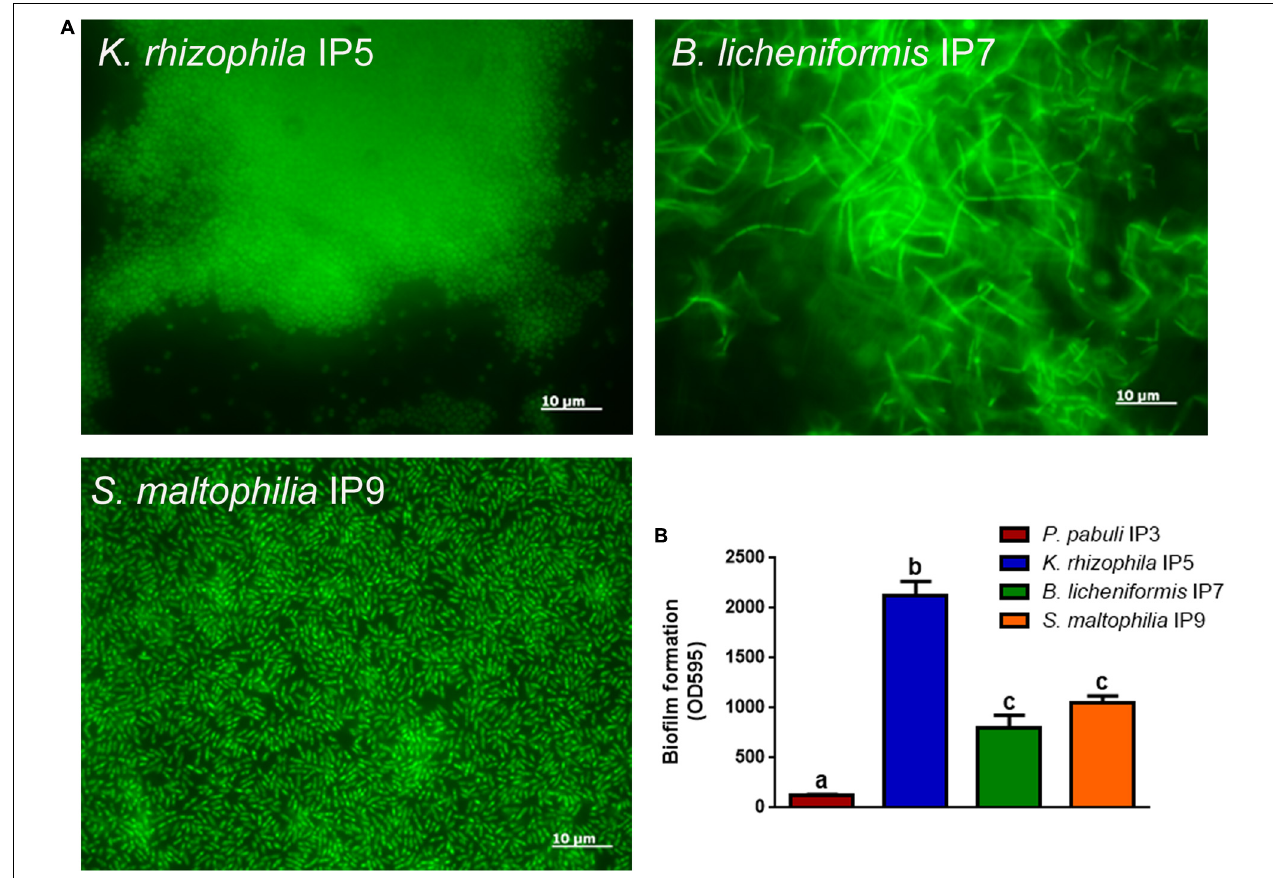
FIGURE 3 | Biofilm formation on glass or plastic surfaces. (A) Fluorescence microscope images of the different bacterial strains forming biofilm on glass. (B) Biofilm formation ability of the bacteria on plastic. To evaluate statistical significance, a one-way ANOVA analysis with the Bonferroni post-test was used (different letters indicate p <